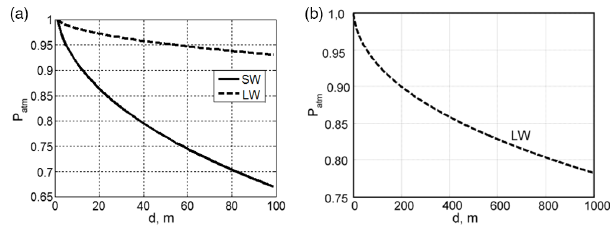
Figure 2. Characteristics of atmospheric transmission coefficient P atm = f ( d ) for AGEMA 880 as a function of the camera–object distance d for LOWTRAN model (Eq. 1) and T atm = 15 ◦ C, ω % = 50%, for (a) d <100m (LW and SW camera) and (b) d <1000m (LW camera for further